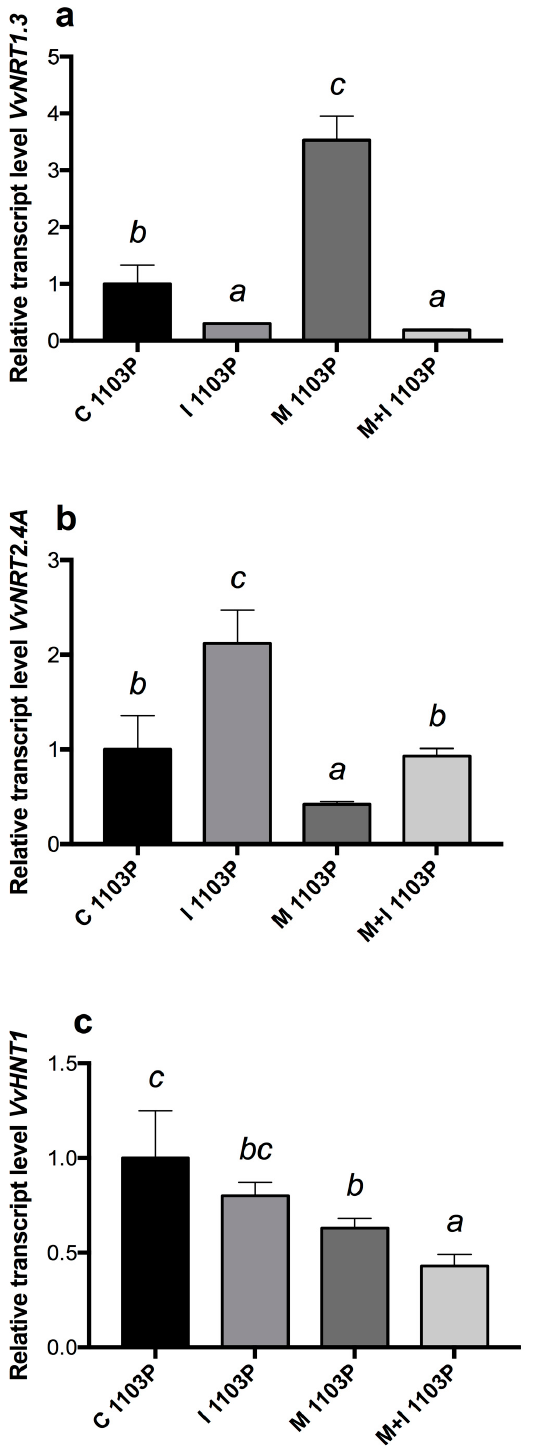
Figure 1. Expression changes of nitrogen-related genes in 1103P root. All data are expressed as mean ± SD ( n = 3). Different lowercase letters above the bars indicate significant differences according to Tukey’s HSD test ( p < 0.05). C, control plants; I, Inducer-treated plants; M, AMF mixed inoculum- treated plants; M + I AMF mixed inoculum + Inducer-treated plants. ( a ) is the relative expression level of VvNRT1.3 ( b ), is the relative expression level of VvNRT2.4A ( c ), is the relative expression level of VvHNT1 .